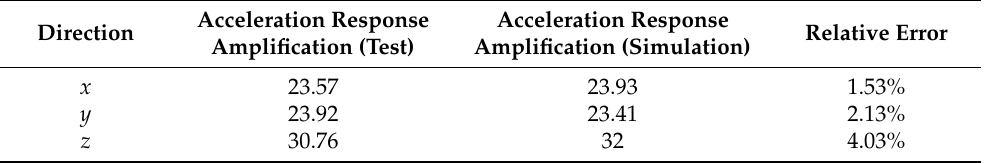
Table 5. Comparison between test and simulation of acceleration amplification.